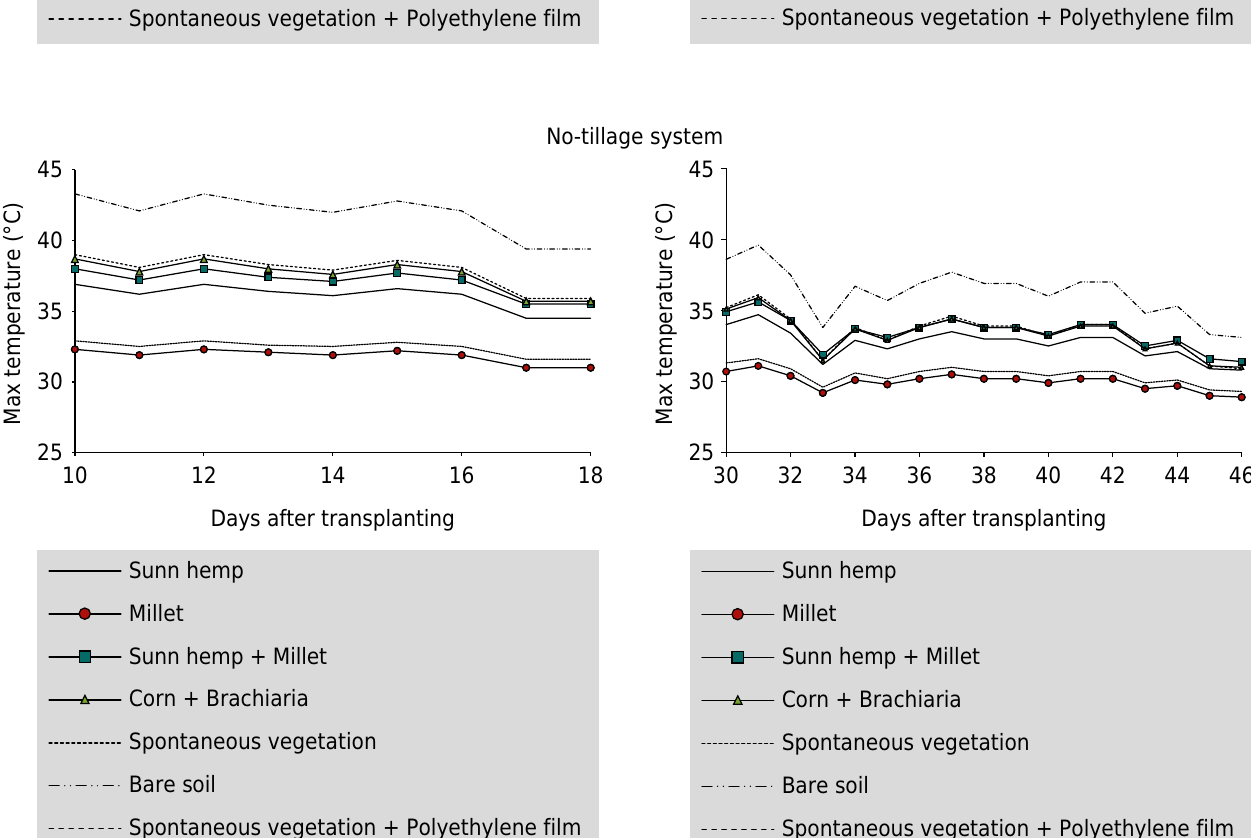
Figure 1. Maximum (Max) daily soil temperatures during the muskmelon cycle according to cropping systems and soil